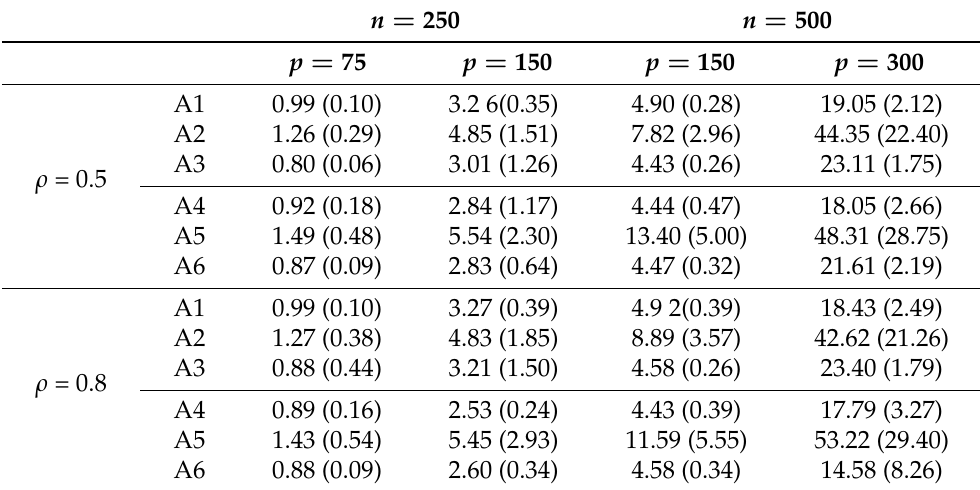
Table 1. Computational time (in seconds) under fixed tuning parameters with different combinations of sample size n and numbers of genetic factors p . The total dimension is pq + p + q + 1 with k = 5 time points and q = 3 environmental